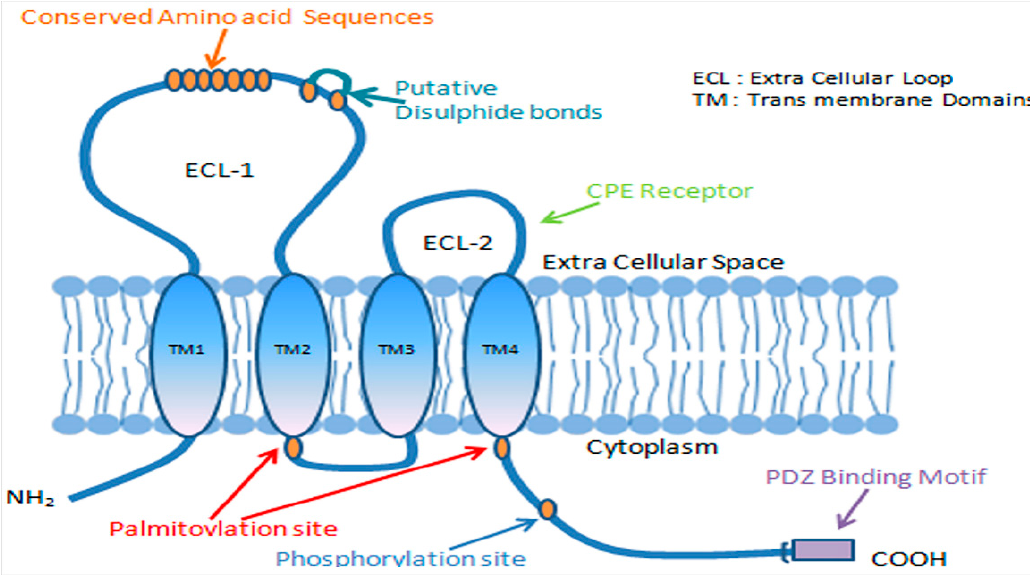
Figure 1. A schematic presentation of tight junction complex involving claudins and other major components. Claudins contain four transmembrane domains (TMD-1, TMD-2, TMD-3, and TMD-4) and two extracellular (ECL) loops. The PDZ-binding domain of the –COOH terminal of claudin undergoes post-transcriptional modification and has been implicated in signal